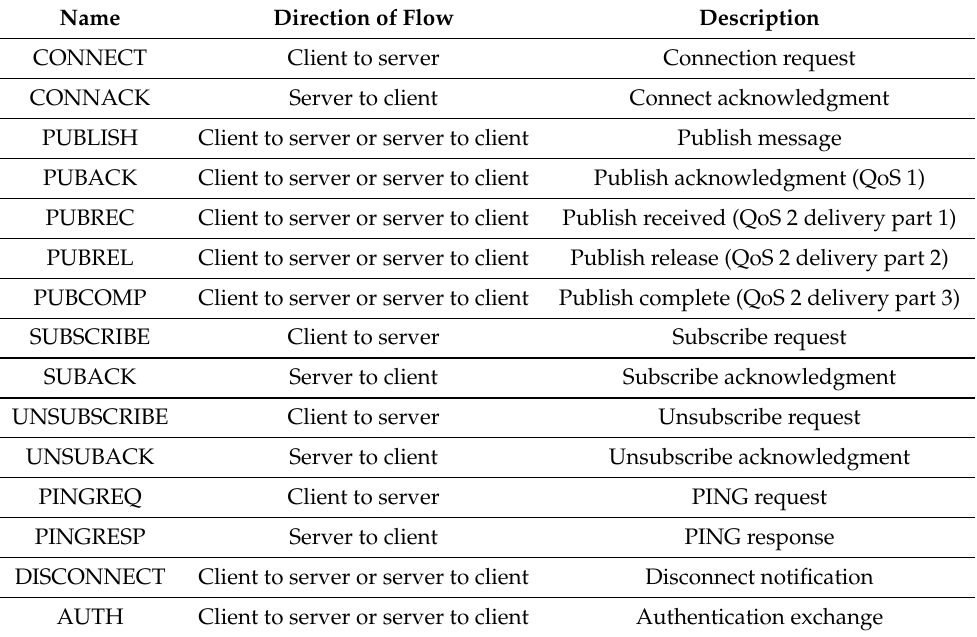
Table 2. MQTT control packet types